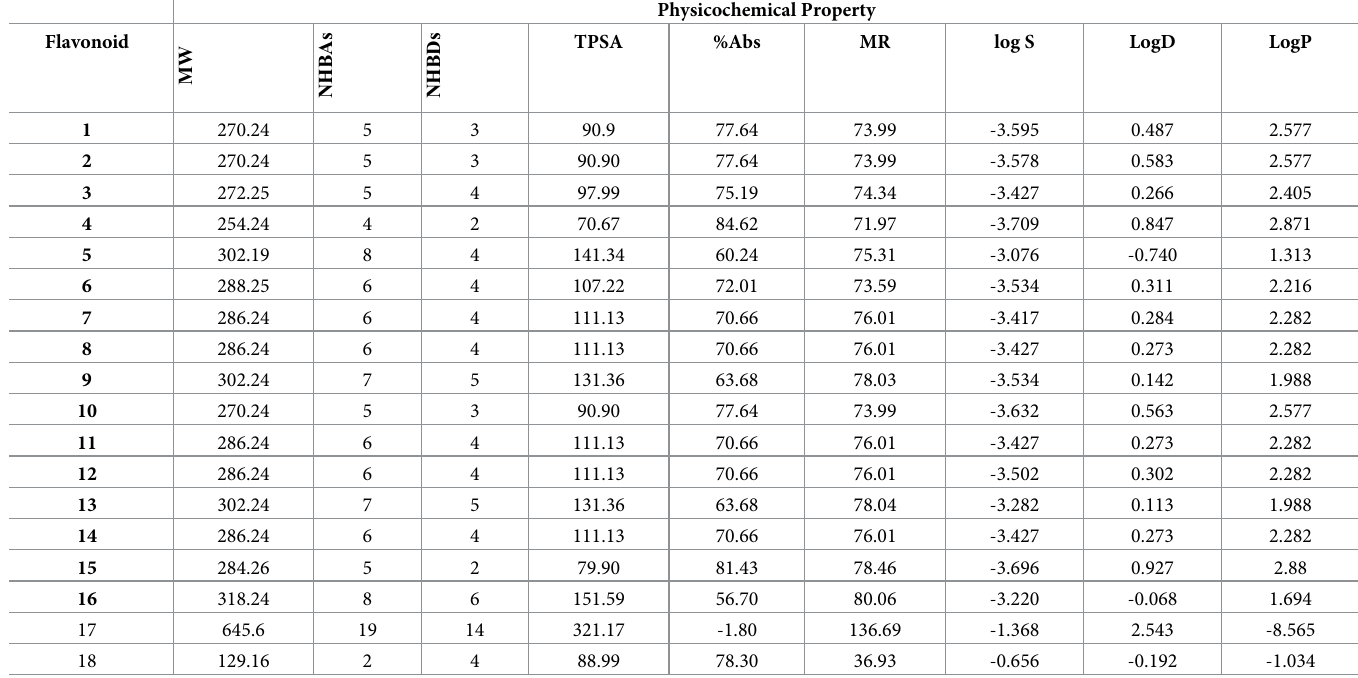
Table 1. The physicochemical property of the flavonoids and the two control